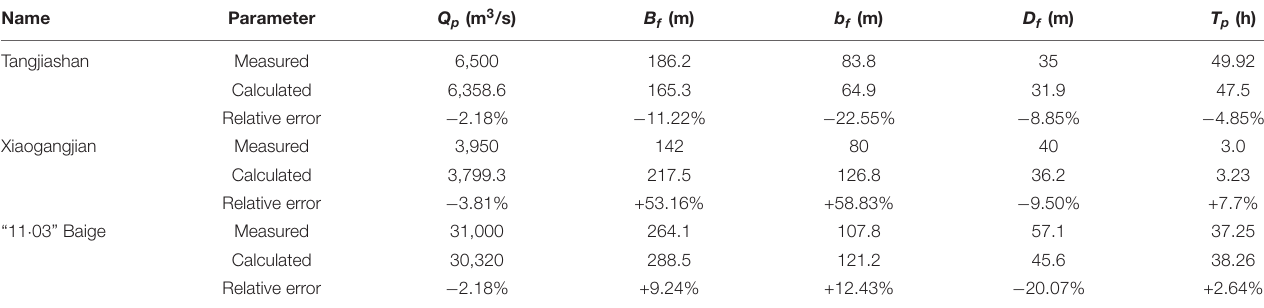
TABLE 7 | Comparison of calculated and measured output parameters for the three landslide